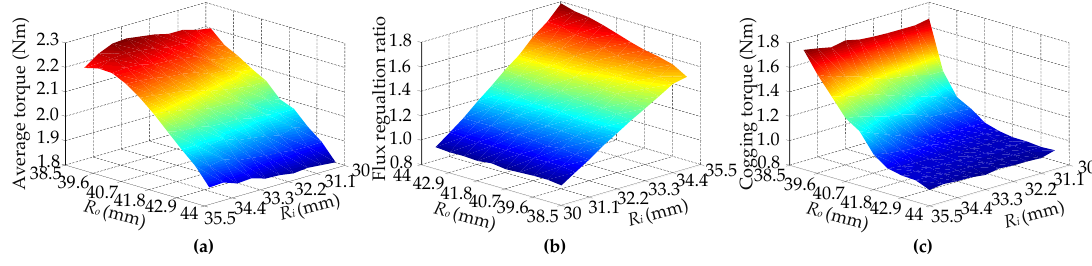
Figure 8. RS optimization results. ( a ) Average torque versus R o and R i ; ( b ) flux regulation ratio versus R o and R i ; ( c ) cogging torque versus R o and R i .